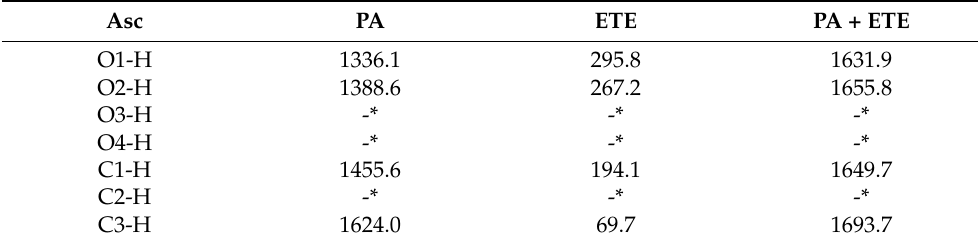
Table 7. Proton affinities (PAs) and electron transfer enthalpies (ETEs) in kJ/mol for ascorbic acid (Asc) calculated at the M06-2X/6-31 G(2d,2p) level of theory in the gas phase. Asc PA ETE PA + ETE O1-H 1336.1 295.8 1631.9 O2-H 1388.6 267.2 1655.8 O3-H -* -* -* O4-H -* -* -* C1-H 1455.6 194.1 1649.7 C2-H -* -* -* C3-H 1624.0 69.7